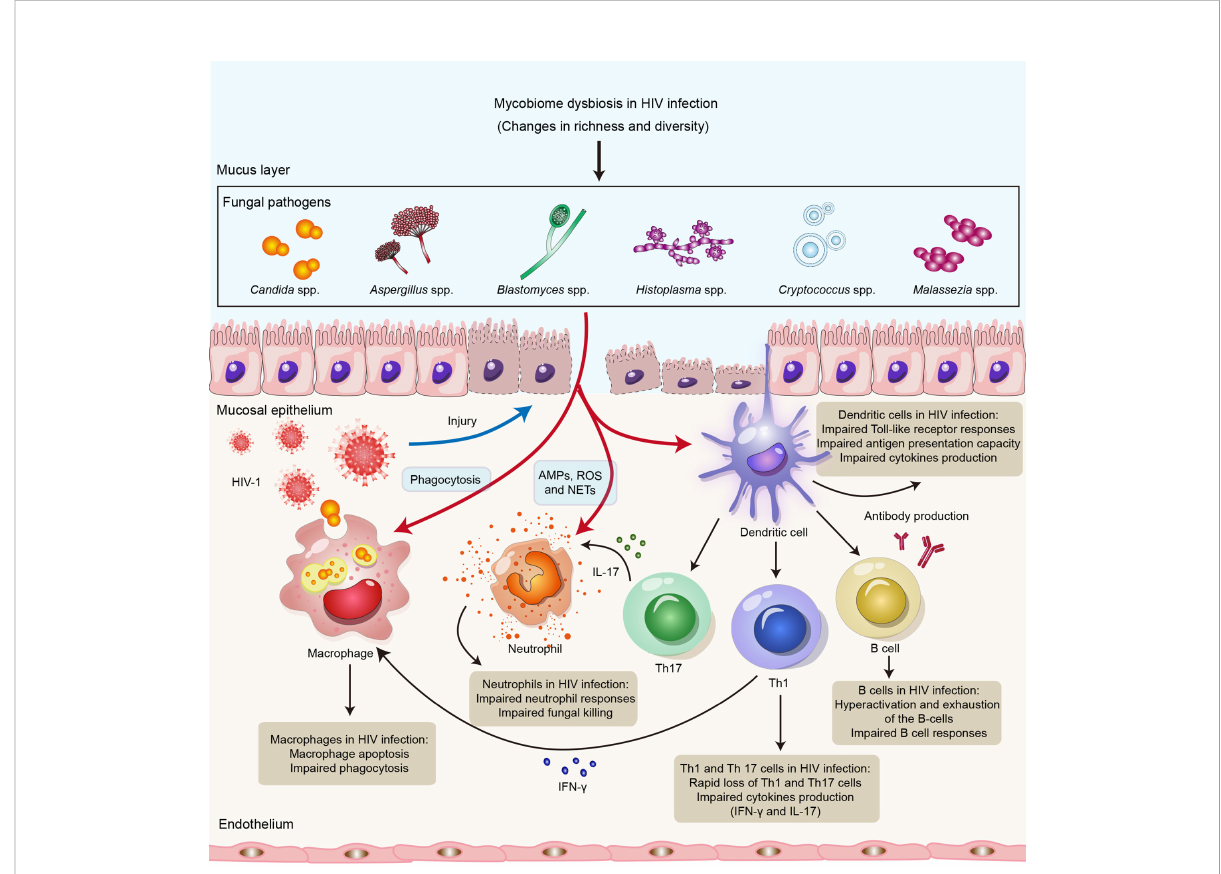
FIGURE 1 Impact of HIV infection on innate and adaptive immune responses to opportunistic fungal pathogens. HIV infection might lead to impairment of the innate and adaptive arms of the immune system, resulting in susceptibility to opportunistic fungal infections. Neutrophils control fungal infections through multiple mechanisms, including AMPs, ROS and NETs. Macrophages directly kill invading fungi through phagocytosis. DCs recognize fungal antigens by PRRs and also promote Th1 and Th17 immunity, as well as antibody production, to clear fungal infections. HIV can not only lead to impairment of neutrophil responses, phagocytosis of macrophages and the antigen presentation capacity of DCs but also cause defects in Th1, Th12 and B-cell responses. Abbreviations: AMPs, antimicrobial peptides; ROS, reactive oxygen species; NETs, neutrophil extracellular traps; DCs, dendritic cells; Th1, T helper 1 cell; Th17, T helper 1 cell; PRR, pattern recognition